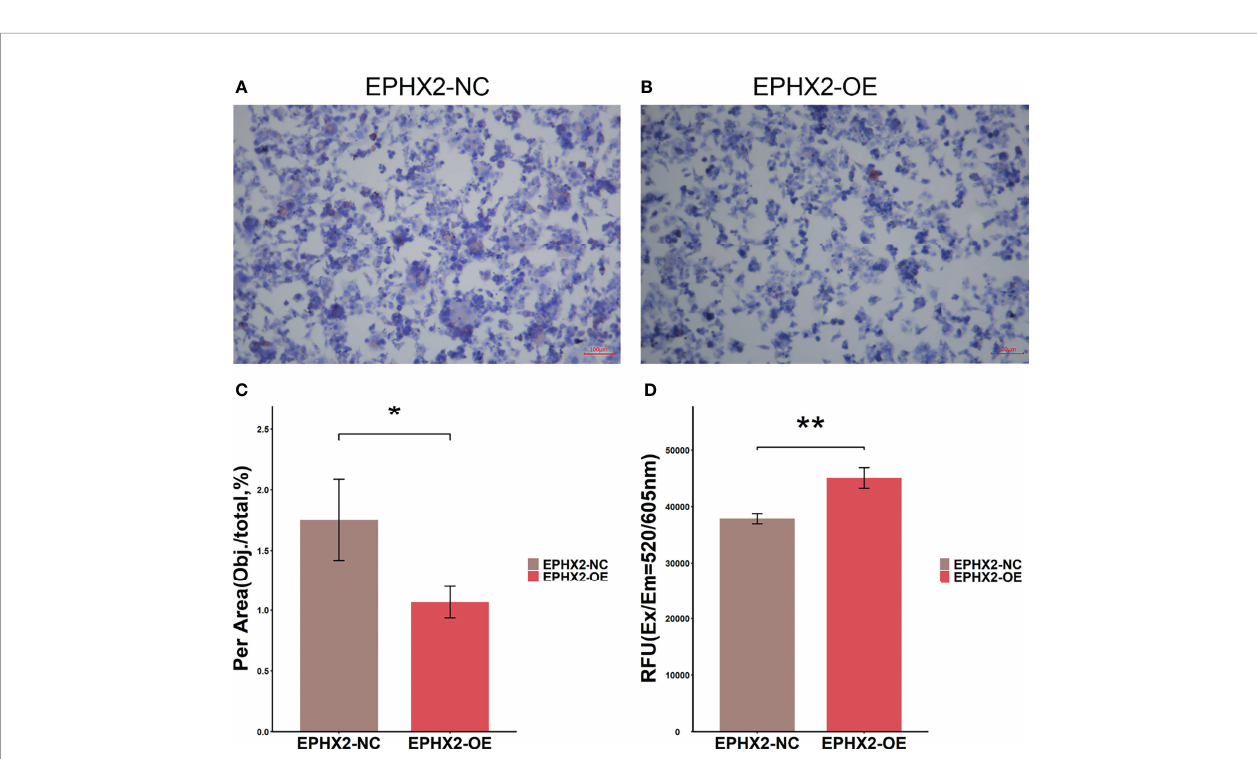
FIGURE 9 | Lipid drop Oil Red O staining and detection of ROS in HCT116 cells. (A) Lipid drop Oil Red O staining in EPHX2-NC group. (B) Lipid drop Oil Red O staining in EPHX2-OE group. (C) The area (Obj./total: the red stain occupying the total area of visual fi eld) was calculated using ImageJ pro plus6, which randomly selected high, medium, and low ORO staining images from each of the three repeated experiments. Statistical signi fi cance was determined with ANOVA. Compared with the EPHX2-NC group, the EPHX2-OE group had decreased ROS level. * p < 0.05; original magni fi cation, 100×; scale bars, 100 m m. (D) ROS in the two groups was detected using the enzyme labeling instrument. ANOVA was used to compare the mean values after absorbance conversion. Compared with the EPHX2-NC group, the EPHX2-OE group had increased ROS level, ** p <